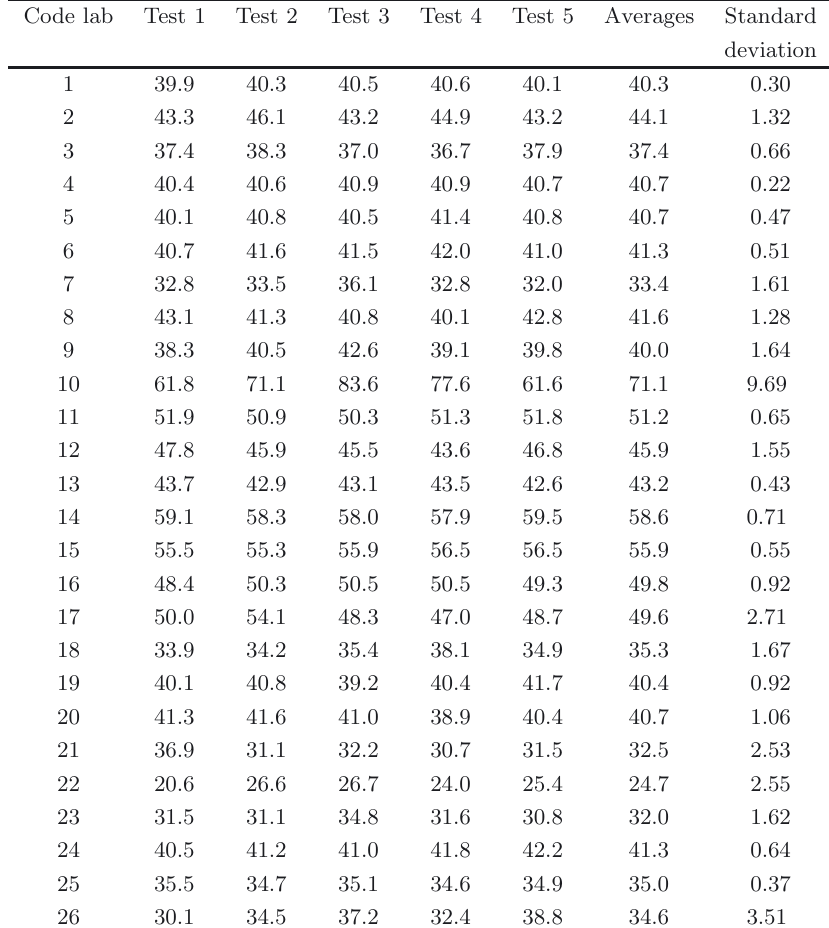
Table 2. Histamine (mg/kg), in the level 1 matrix obtained by the 26 participating laboratories. Code lab